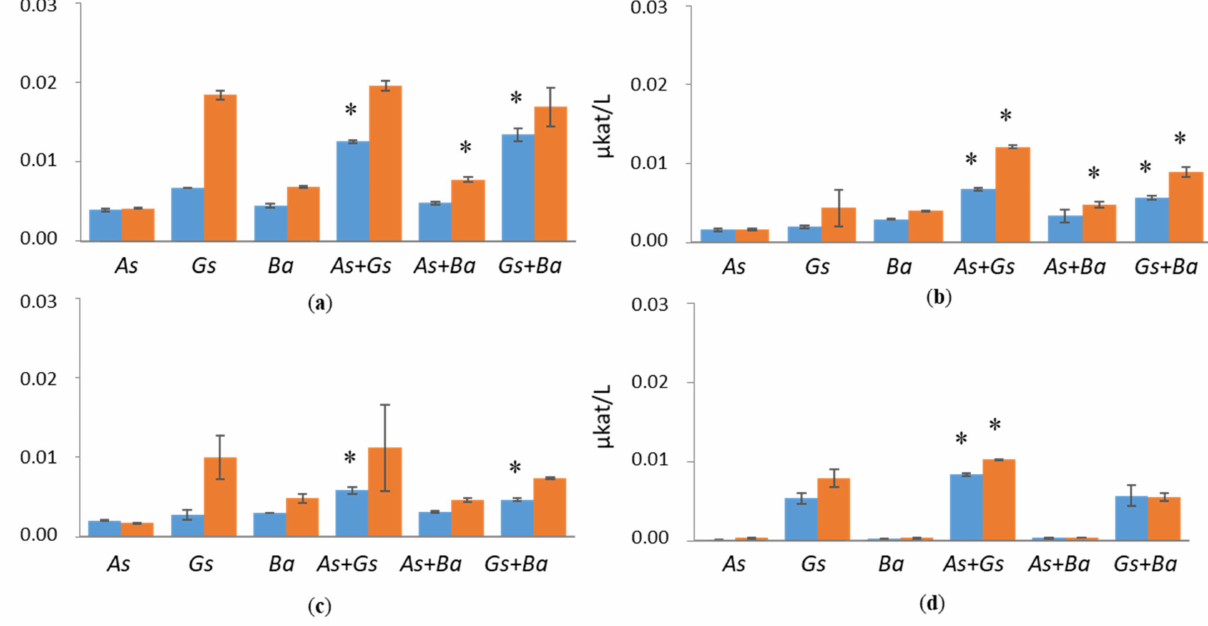
Figure 7. β -mannosidase (MND) activities at early (day 10, marked in blue) and late time points (day 24, marked in red) in single and co-cultivation on ( a ) birch, ( b ) spruce, ( c ) pine wood and ( d ) Avicel. As = A. sinuosa , Gs = G. sepiarium , Ba = B. adusta , As + Gs = A. sinuosa and G. sepiarium , As + Ba = A. sinuosa and B. adusta , Gs+Ba = G. sepiarium and B. adusta . Error bars refer to standard deviation (SD) ( n = 3). * indicates statistical difference among single and co-cultivations ( p <